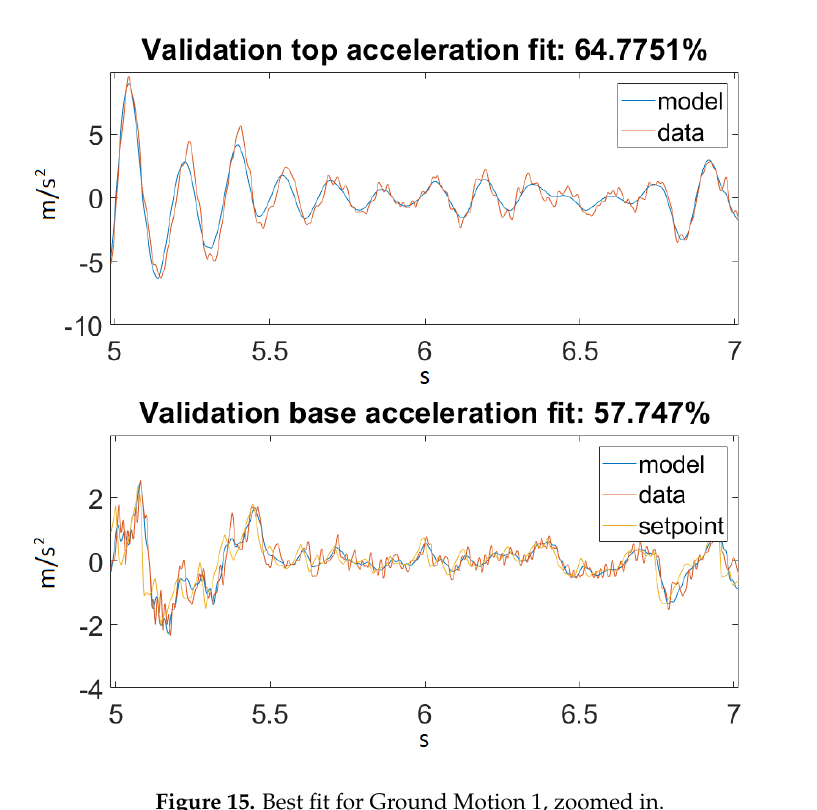
Figure 15. Best fit for Ground Motion 1, zoomed in.